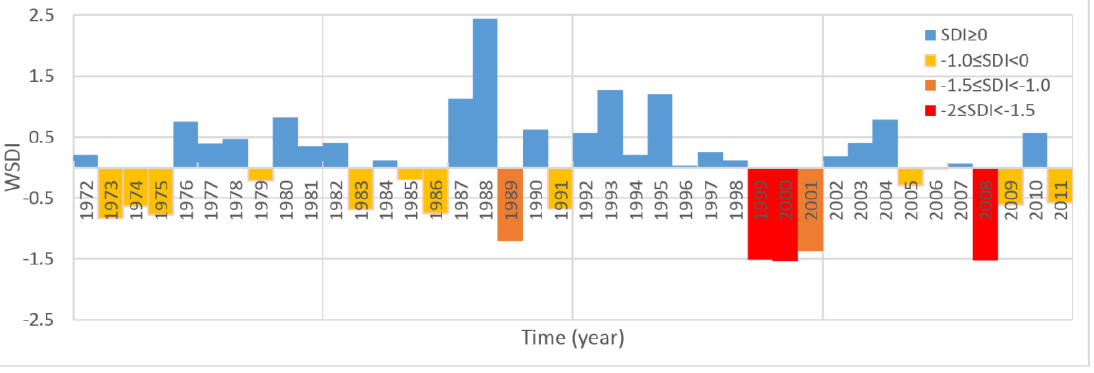
Figure 9. Weighted SDI-12 series for yearly periods.